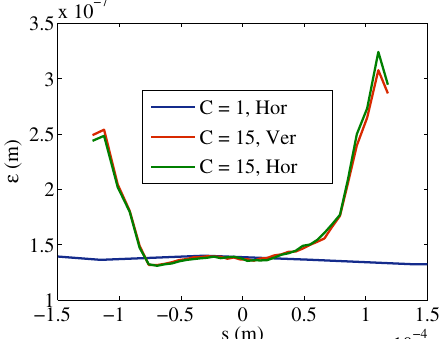
FIG. 10. Simulated horizontal slice emittance along the bunch for a compression factor of 15 obtained by tracking the beam in the bunch compressor using the 1D model of CSRT RACK . The horizontal slice emittance along the bunch before compression and the vertical after compression are also shown for comparison.